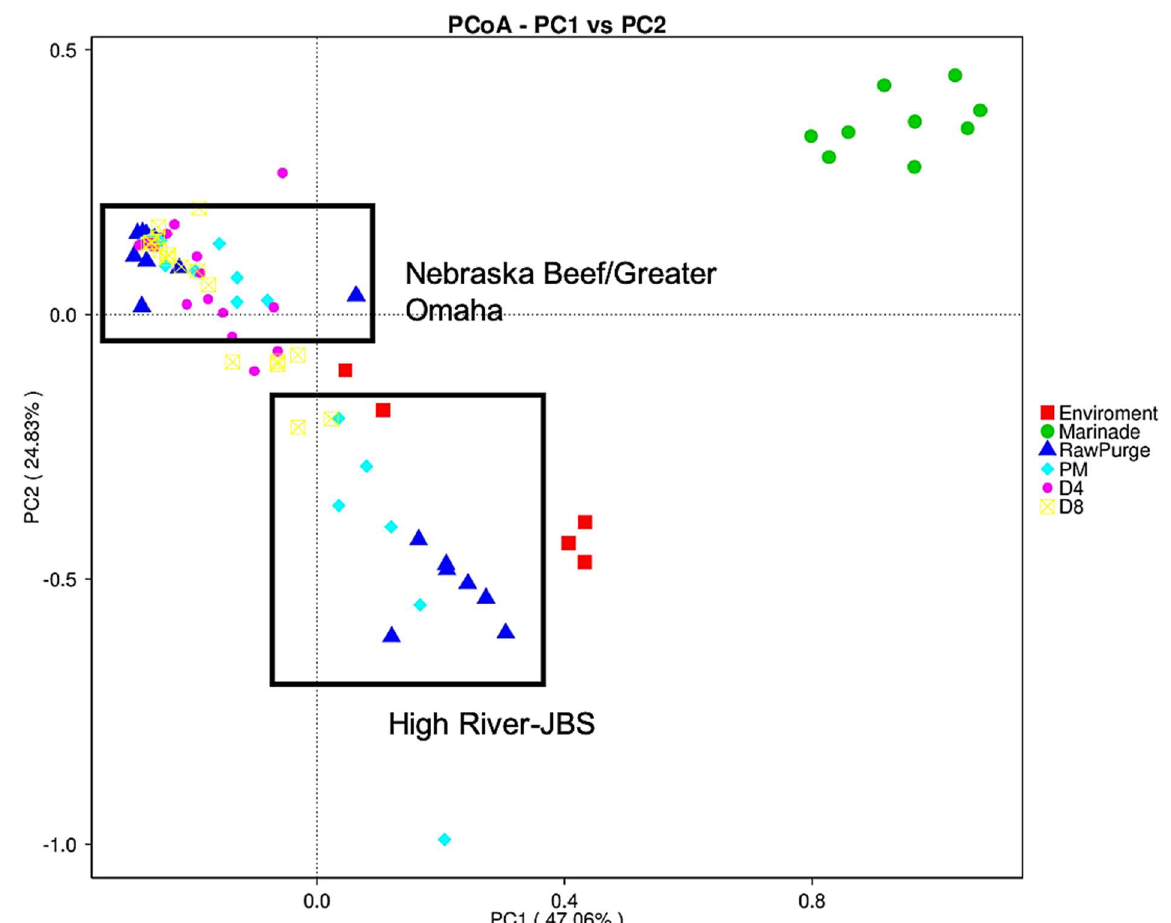
Figure 8. UniFrac analysis of the microbiome of all three processors combined (Nebraska Beef, Greater Omaha, and High River-JBS). Legend: the lab environment (Environment), biltong marinade (Marinade), raw meat/purge after fabrication (RawPurge), beef post-marination (PM), marinated beef dried four days (D4) and marinated beef dried eight days (D8).